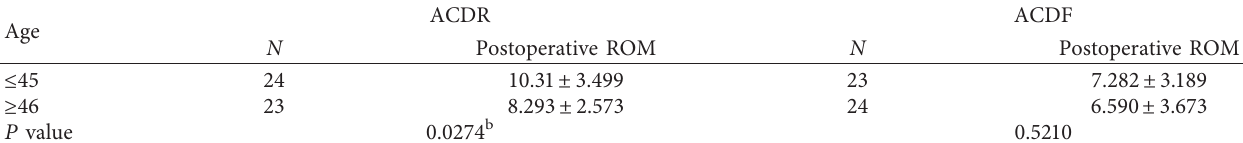
Table 2: Age and postoperative ROM outcome a